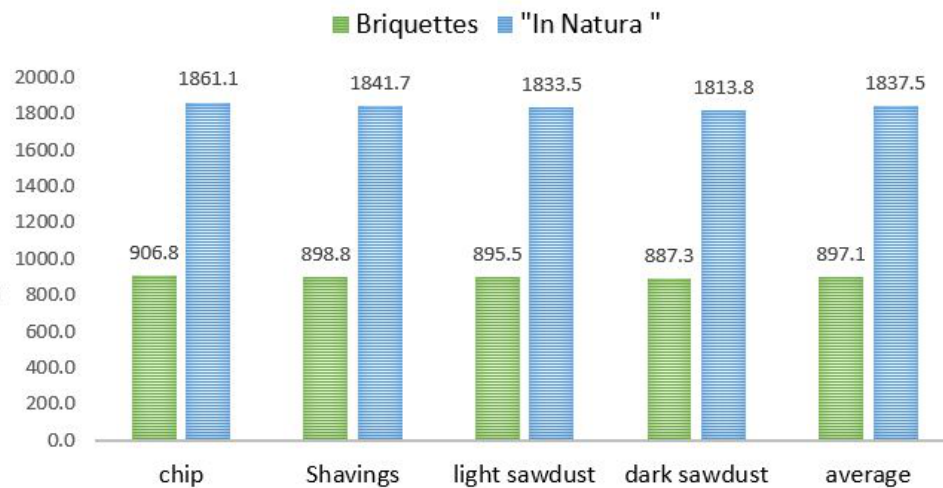
Figure 8. Comparison of the amount of waste required for the generation of 1 MWh from briquettes and “in natura”